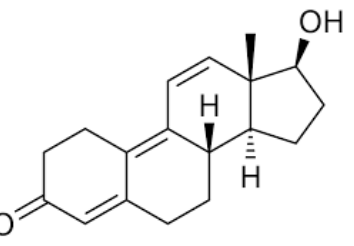
Figure 38. Chemical structure of trenbolone. Formula: C 18 H 22 O 2.